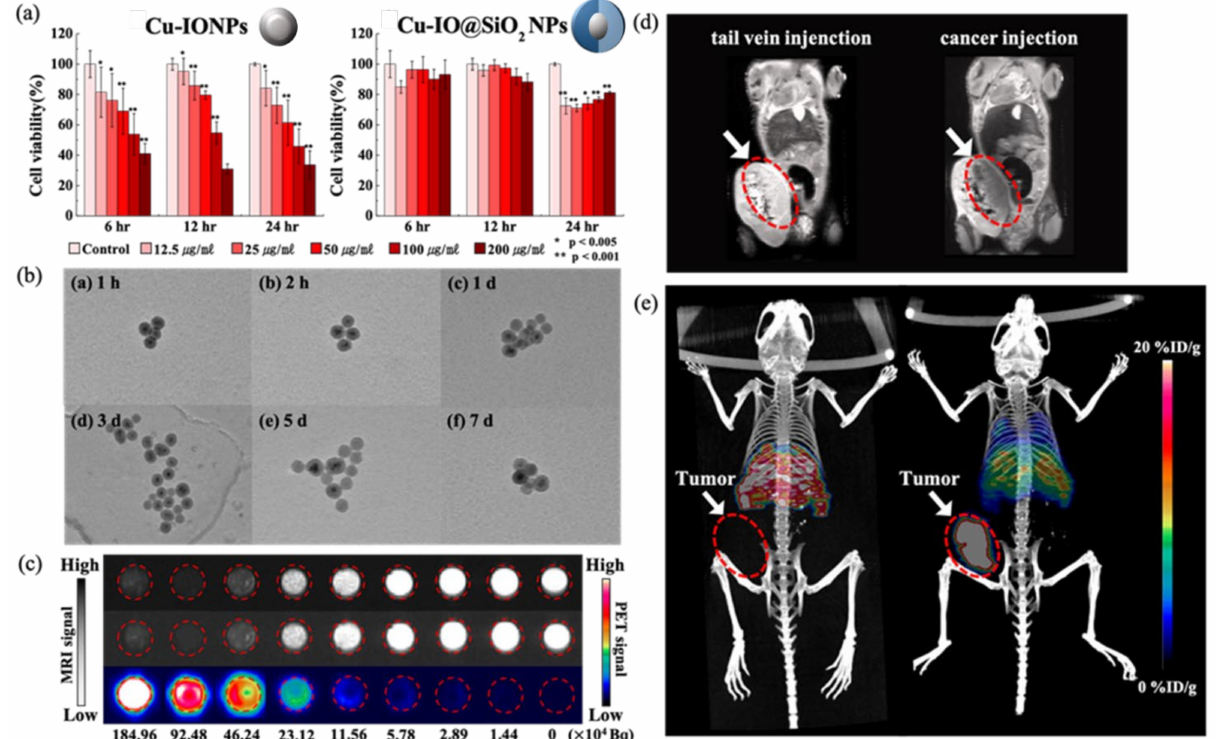
Figure 5. ( a ) Cell viability results examined by the CCK-8 using HUVECs as a function of time with varying concentrations to assess the cytotoxicity. ( b ) Representative TEM images for Cu–IO@SiO 2 NPs incubated in SBF at 37 ◦ C for (b-a) 1 h, (b-b) 2 h, (b-c) 1 d, (b-d) 3 d, (b-e) 5 d, and (b-f) 7 d. SBF results confirm the stability of core-shell structures when the NPs are injected into the body. ( c ) MRI and PET images were measured with varying concentrations of NPs which were diluted half consecutively starting from 184.96 × 10 4 Bq down to 1.44 × 10 4 Bq to examine the contrast performance. ( d ) MR images and ( e ) PET images were measured in 3 h after injecting the NPs into the BALB/c mice. Intravenous injection at the tail (left of ( d , e )) and direct injection into cancer (intratumoral) (right of ( d , e )) of each mouse model. Tumor: white arrows; tumor size and position: red dotted